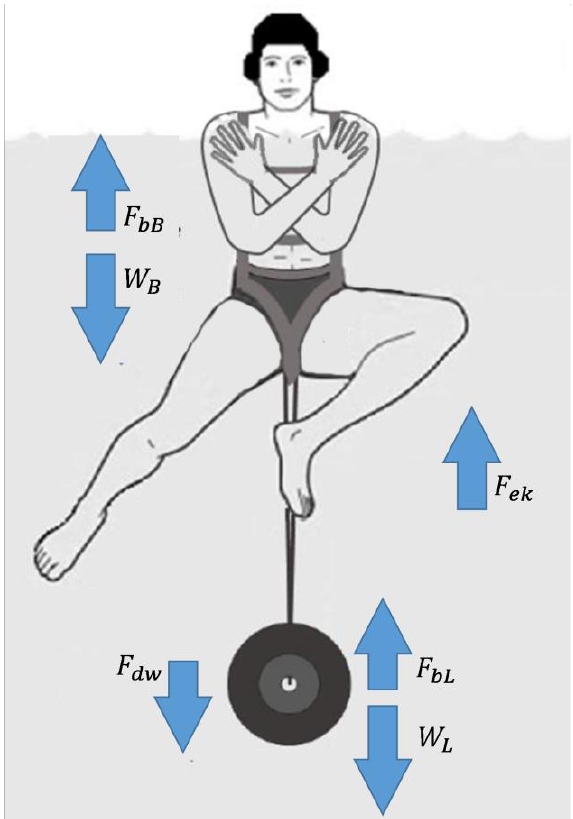
Figure 1. Frontal view of water polo overload test (WOT) conditions and acting forces. Buoyancy force of the subject ( F bB ), Body weight of the subject ( W B ), eggbeater kick force ( F ek ), buoyancy force of the load ( F bL ), weight of the load ( W L ), force relative to power that is wasted to accelerate water downwards ( F dw ).